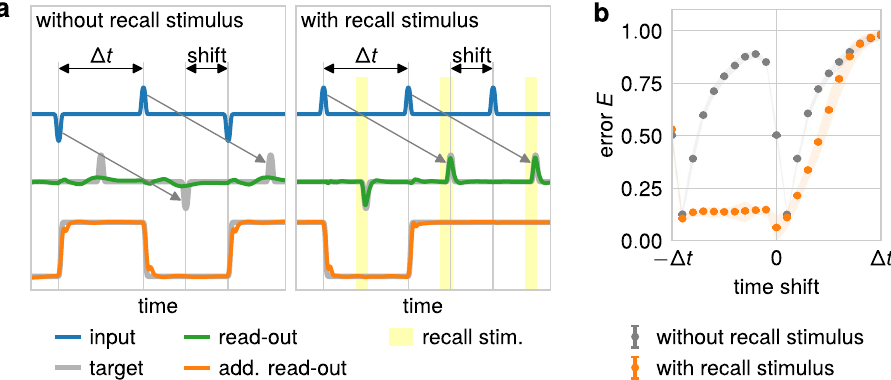
Figure 6. Prediction of the influence of an additional recall stimulus. ( a ) An additional temporal shift is introduced between input and output pulse. In the second setup (lower row) a recall stimulus is applied to the network to trigger the output. This recall stimulus is not relevant for the storage of the task-relevant sign. ( b ) In general the temporal shift increases the error of the system (gray dots; each data point indicates the average over 20 trials) as the system has already reached an attractor state. Introducing a recall stimulus (orange dots) decreases the error for all negative shifts as the system is pushed out of the attractor and the task-relevant information can be read out. This effect diminishes for positive temporal shifts as the system has already forgotten the corresponding